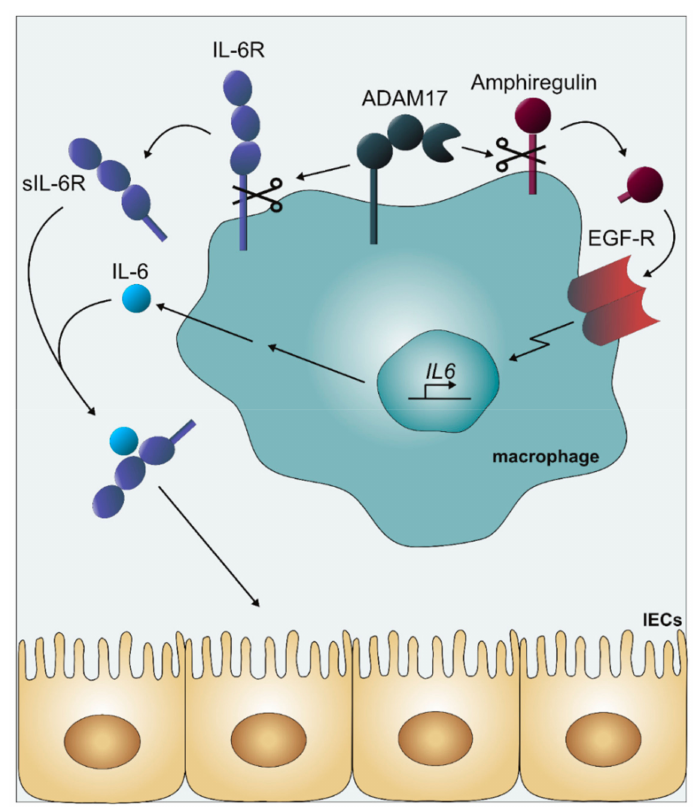
Figure 3. Involvement of ADAM17 in the formation of colon cancer. Under inflammatory conditions, ADAM17 cleaves the membrane-bound EGF-R ligand amphiregulin, leading to the stimulation of the EGF-R on macrophages. This EGF-R stimulation on macrophages leads to increased IL-6 synthesis via transcriptional stimulation. Moreover, activation of ADAM17 under inflammatory conditions leads to cleavage of the membrane-bound IL-6R on macrophages to generate soluble IL-6R (sIL-6R). IL-6 in complex with sIL-6R leads to stimulation of intestinal epithelial cells (IECs) via IL-6 trans-signaling resulting in colon cancer formation